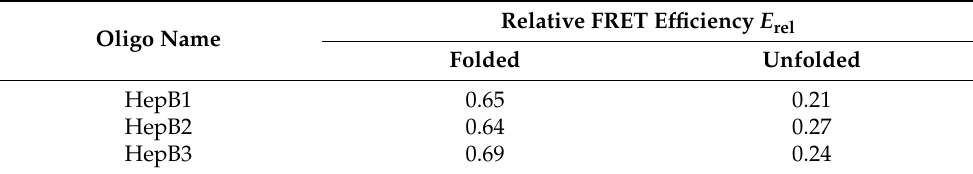
Table 1. Relative fluorescence efficiency values of HepB oligos in folded and unfolded conformations. All experiments were performed in presence of potassium ion.